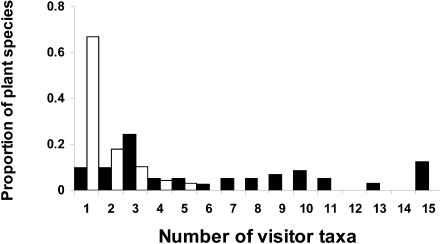
Number of Insect Species Pollinating Orchid Species in the Northern and Southern HemispheresEurope and North America, closed bars, n = 41; southern Africa, open bars, n = 73. Redrawn from Johnson and Steiner (2003).